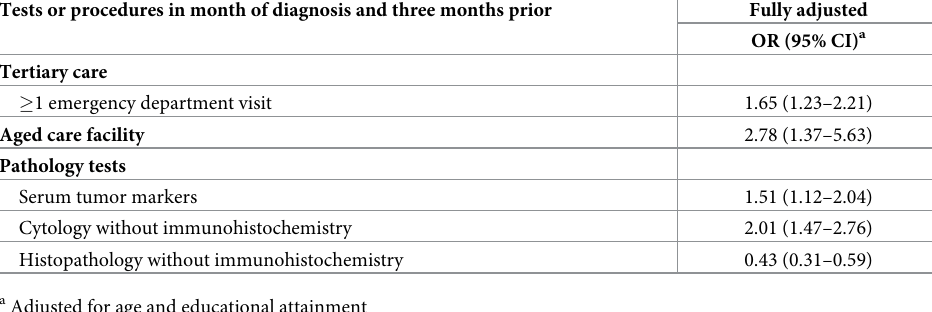
Table 3. Association between recent health service use, cancer-related diagnostic tests and procedures, and diag- nosis of CUP compared to metastatic cancer of known primary. Tests or procedures in month of diagnosis and three months